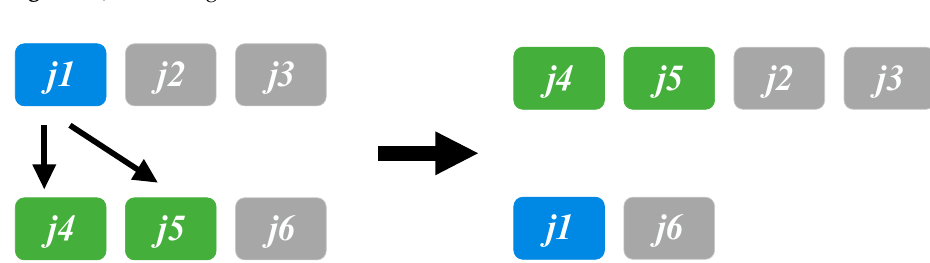
Figure 3. Job moving.